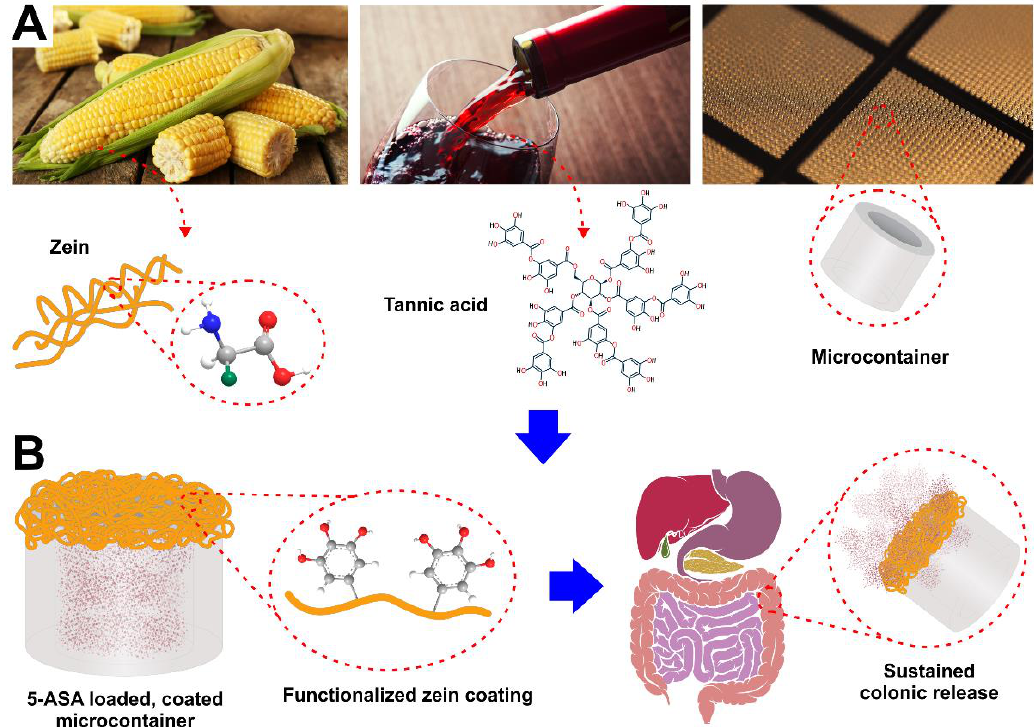
Figure 1. Illustrative concept of the study, which aims to combine the functionalities of zein protein, tannic acid, and MCs ( A ), creating a drug carrier for sustained colonic delivery of 5-ASA ( B ).